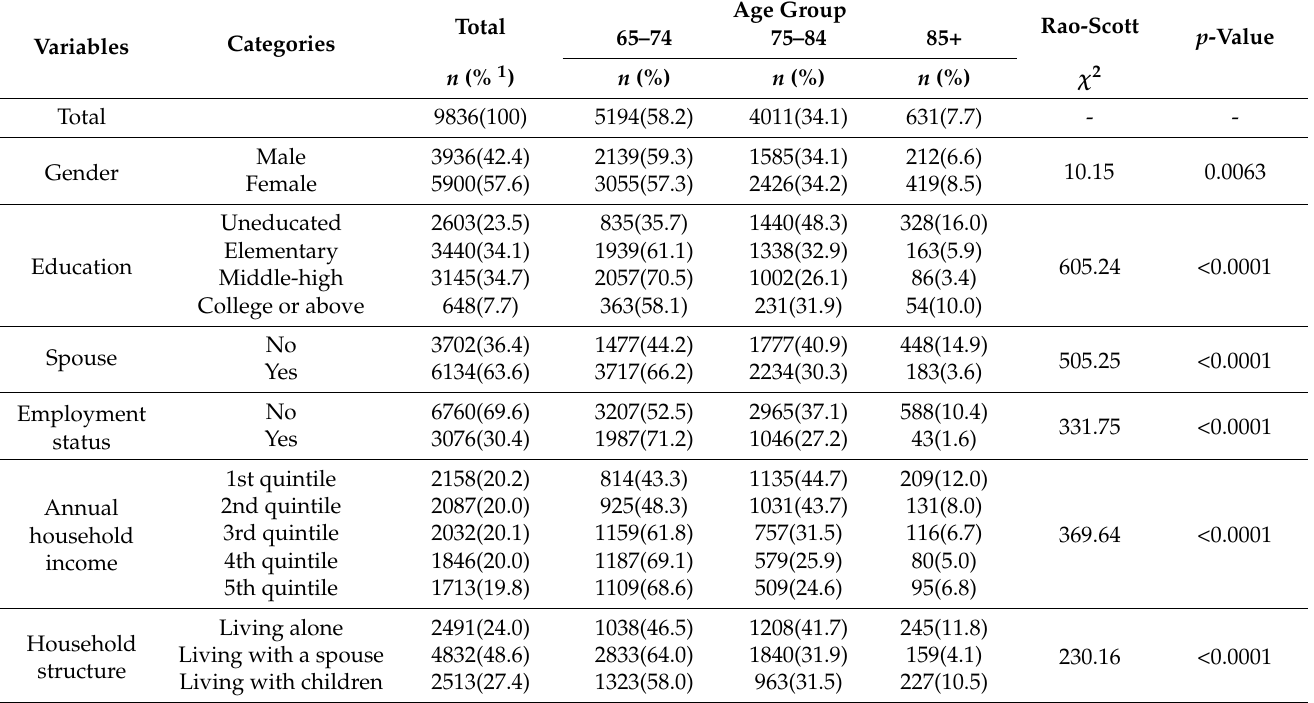
Table 1. Sociodemographic characteristics by age group and homogeneity test between each variable and age group.